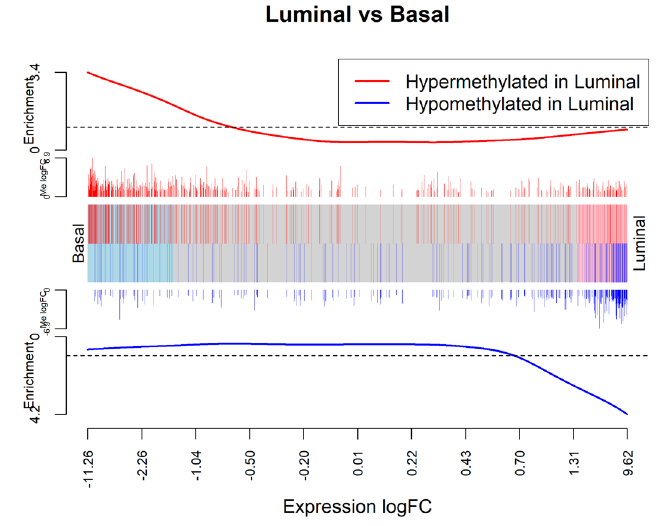
Figure 9. Barcode plot showing strong negative correlation between expression changes and methylation changes when luminal cells are compared to basal. The plot is analogous to Figure 8 with the DM genes now displayed as gene sets and the methylation logFCs now displayed as gene